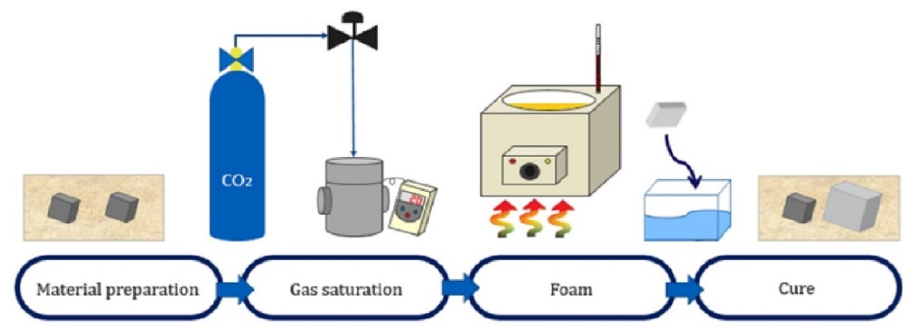
Figure 2. The procedure of the batch